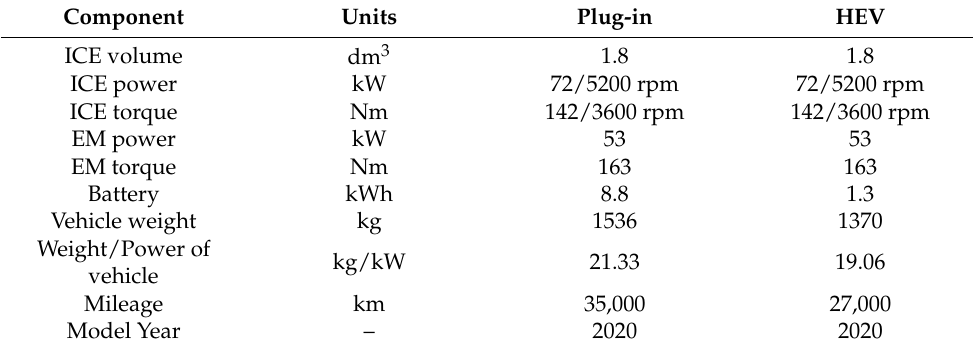
Table 1. The chosen characteristics of hybrid vehicles